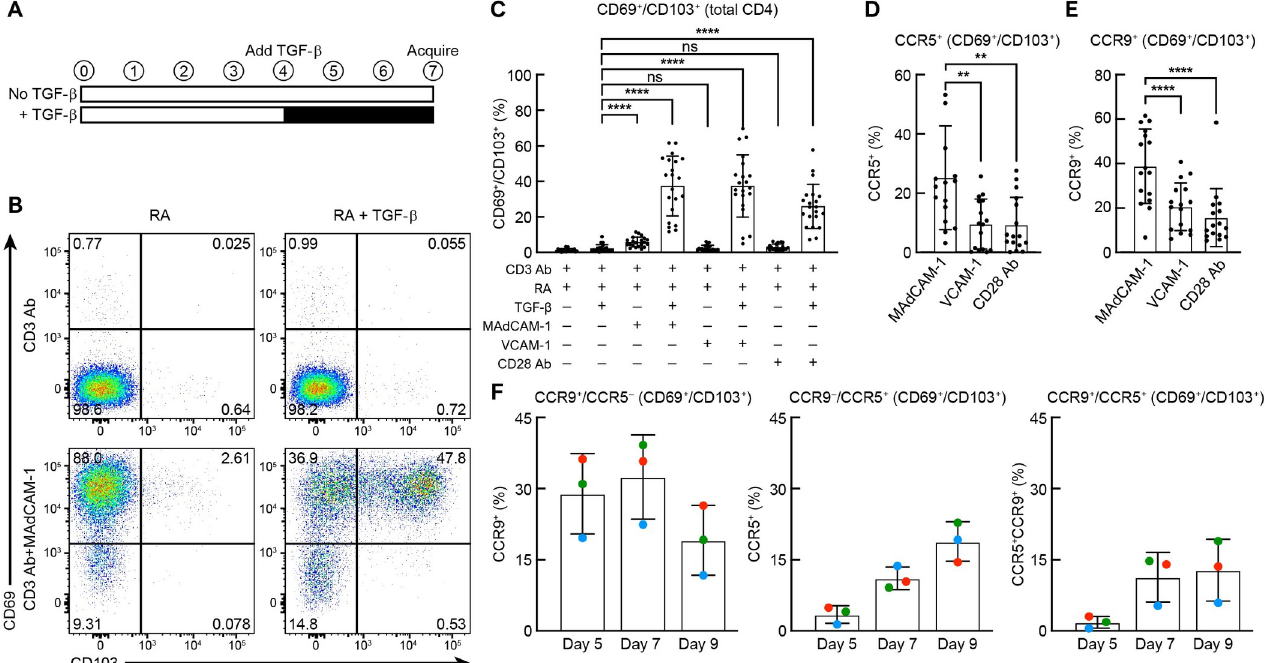
Fig 2. Induction of CD69, CD103, CCR9 and CCR5. ( A ) Schematic of treatment time course. ( B ) Representative flow cytometry dot plot of CD4 + T cells stimulated with CD3 Ab, and CD3 Ab + MAdCAM-1 in presence of RA or RA+TGF- β as indicated. Y-axis: CD69, X-axis: CD103. Percent total cells in each quadrant, as indicated. ( C) Percent expression of CD69 + /CD103 + cells within total CD4 + T cell cultures of 21 donors stimulated with CD3 Ab + RA, CD3 Ab + MAdCAM-1 + RA, CD3 Ab + VCAM-1 +RA, and CD3 Ab + CD28 Ab + RA, in absence or presence of TGF- β , as indicated. ( D ) Percent expression of CCR5 and ( E ) CCR9 within the CD69 + /CD103 + population of 16 donors following MAdCAM-1, VCAM-1 and CD28 Ab stimulation in the presence of RA and TGF- β . ( F ) Percent expression of CCR9 + /CCR5 - , CCR9 - /CCR5 + , and CCR9 + /CCR5 + cells within the CD69 + /CD103 + population from 3 donors on days 5, 7, and 9 following MAdCAM-1 + RA + TGF- β stimulation. ( �� : P < 0.01, ���� : P < 0.0001, two-tailed t test).